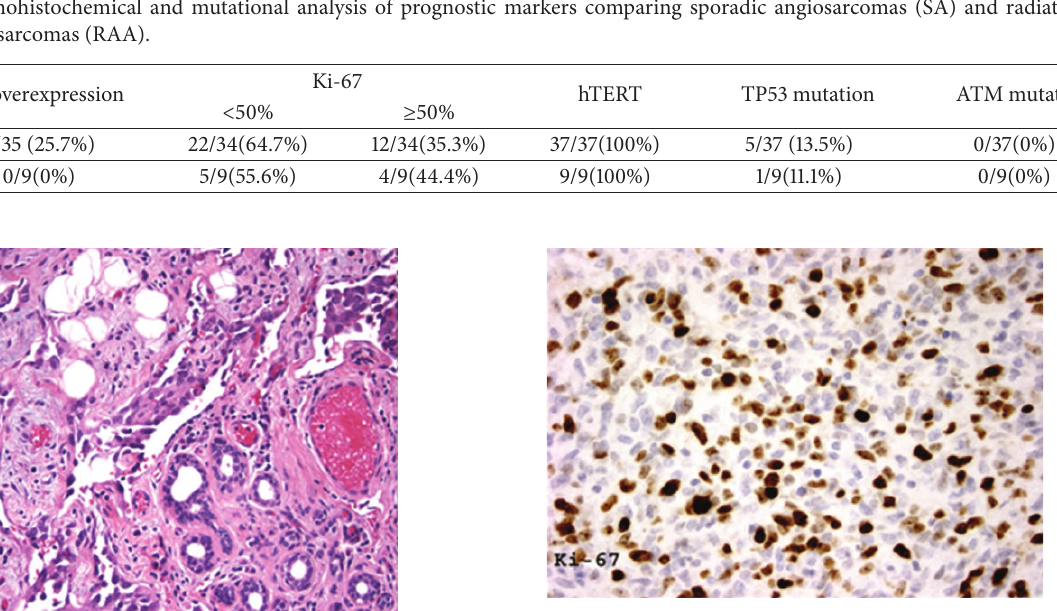
Figure 4: Unlike radiation-associated tumors, the majority of sporadic angiosarcomas of the breast were parenchymal in origin. This micrograph depicts infiltration and entrapment of lobular acini (lower right) by vasoformative angiosarcoma (H&E, 200x).